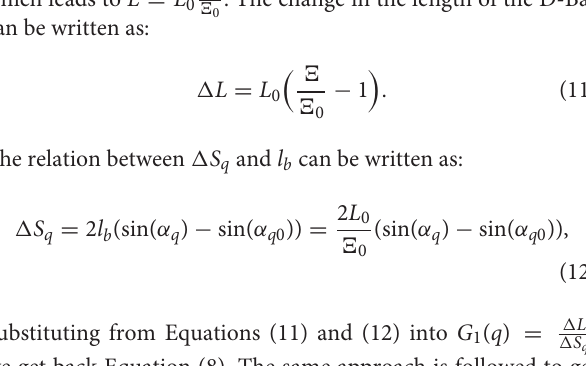
and the abscissa shows complexity q . (A) Planar D-Bar. (B) 3D L 2